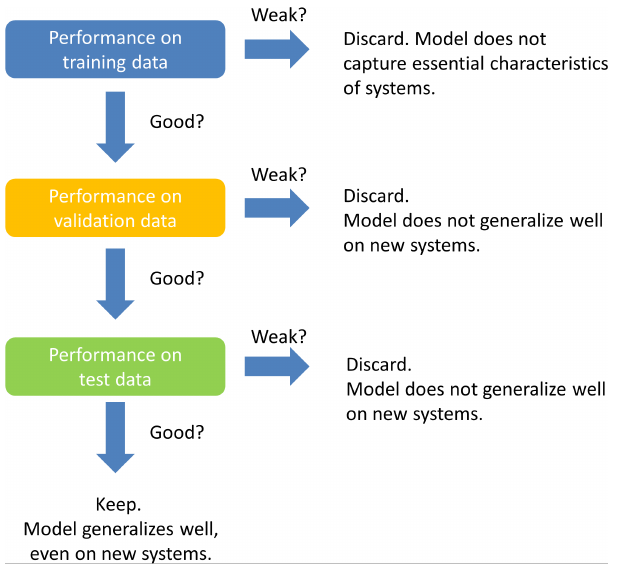
Fig. 1 . Workflow and relationship between training, validation, and test set.